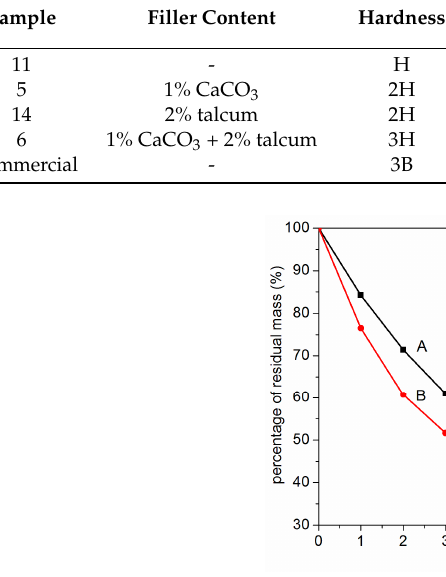
Table 9. Solvent resistance of WUVCW after exposition of 15% NaCl solution.